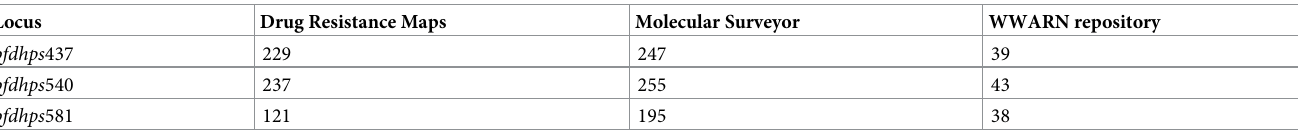
Table 1. Number of data points by data source and gene locus. Locus Drug Resistance Maps Molecular Surveyor WWARN